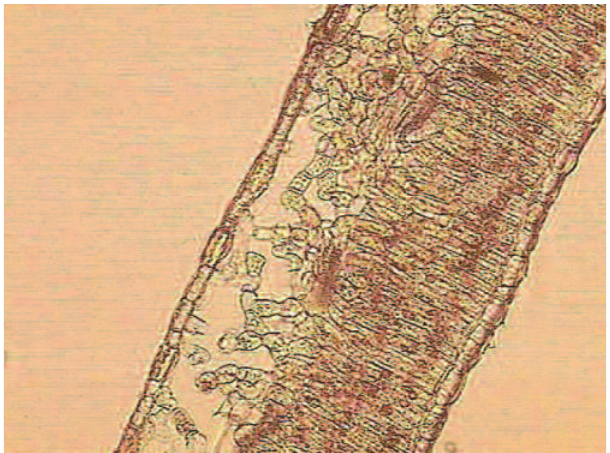
Figure 2. Cross section of the midrib of Ozark Gold leaf shows the thick cuticle of the upper epidermis. Tracheae are relatively narrow (magnification 4×)